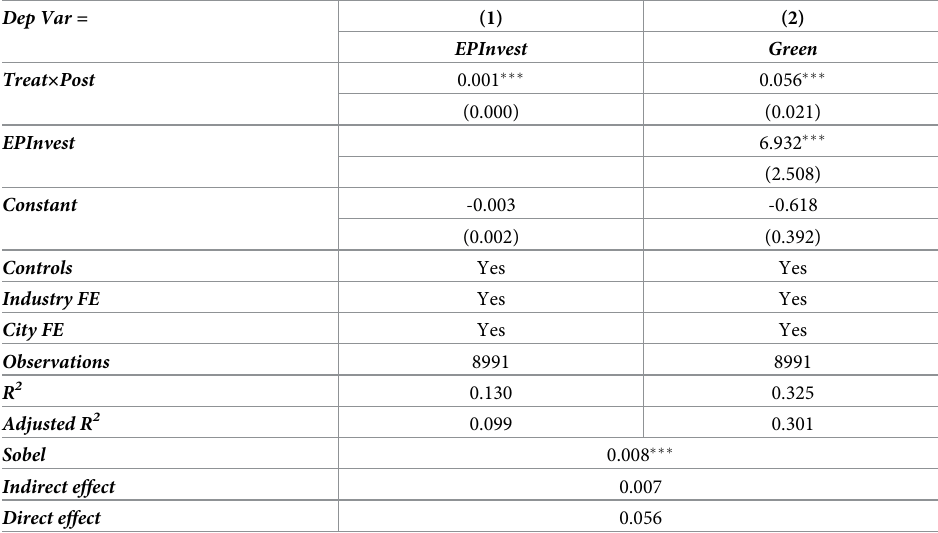
Table 8. Environmental protection investment mechanism regression